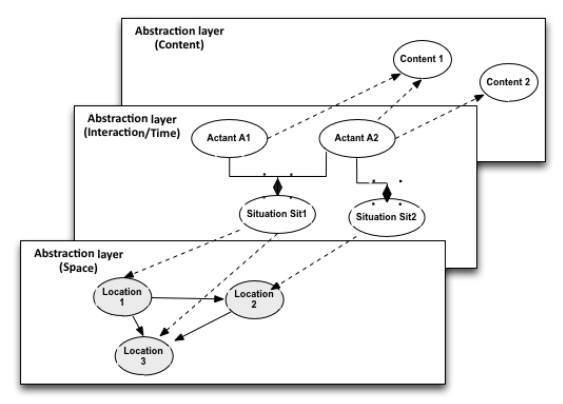
Figure 6. C, I, And E dimensions in the architecture for abstraction